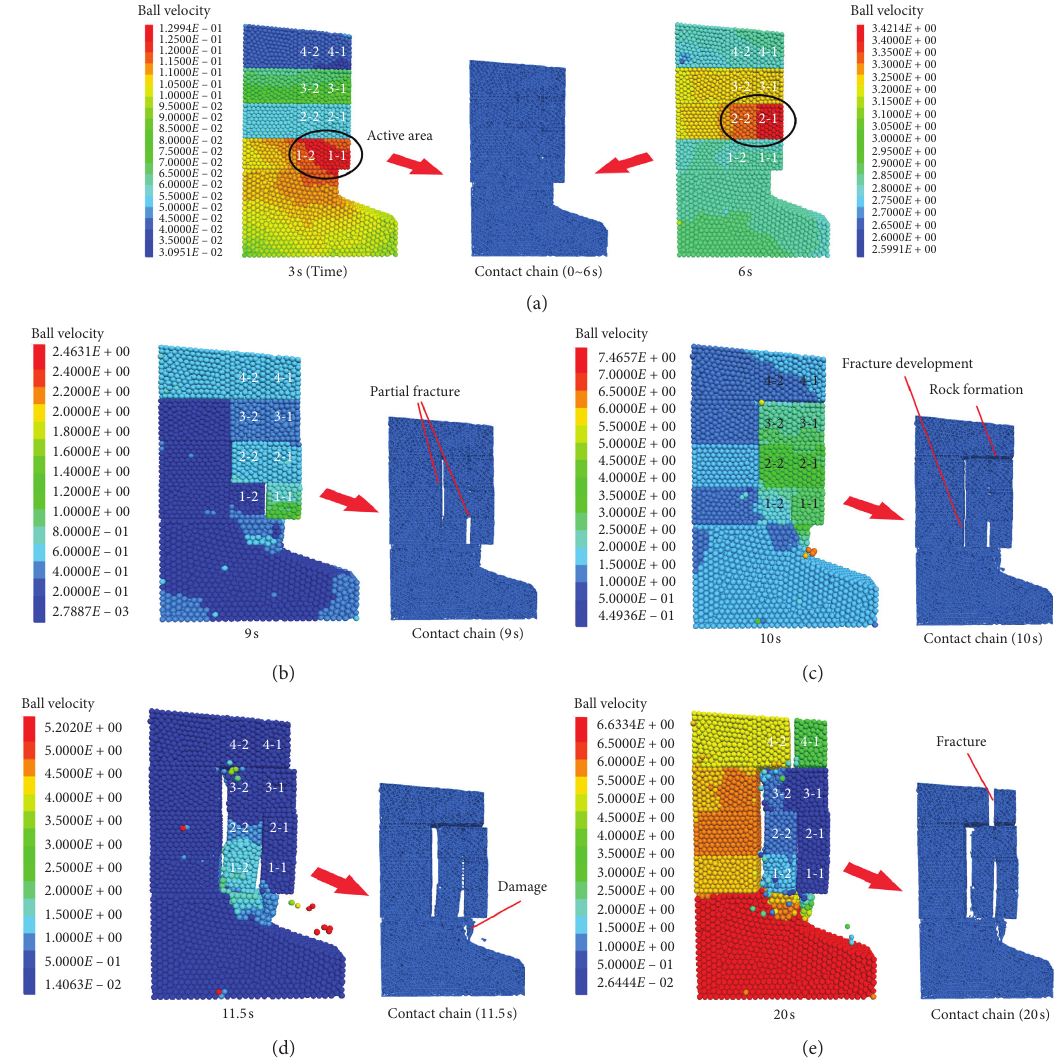
Figure 18: The failure process of the dangerous rock model under different earthquake durations. (a) 0 ∼ 6 s, (b) 9 s, (c) 10s, (d) 11.5s, and (e)